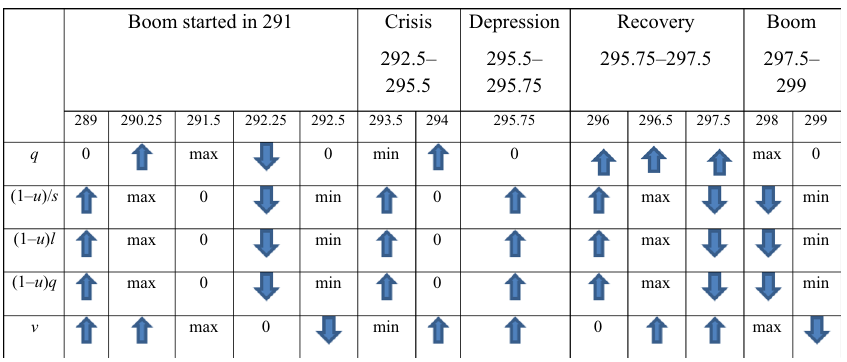
Table 16 Extremes of indicators’ growth rates for the phases of adjacent industrial cycles in L-2